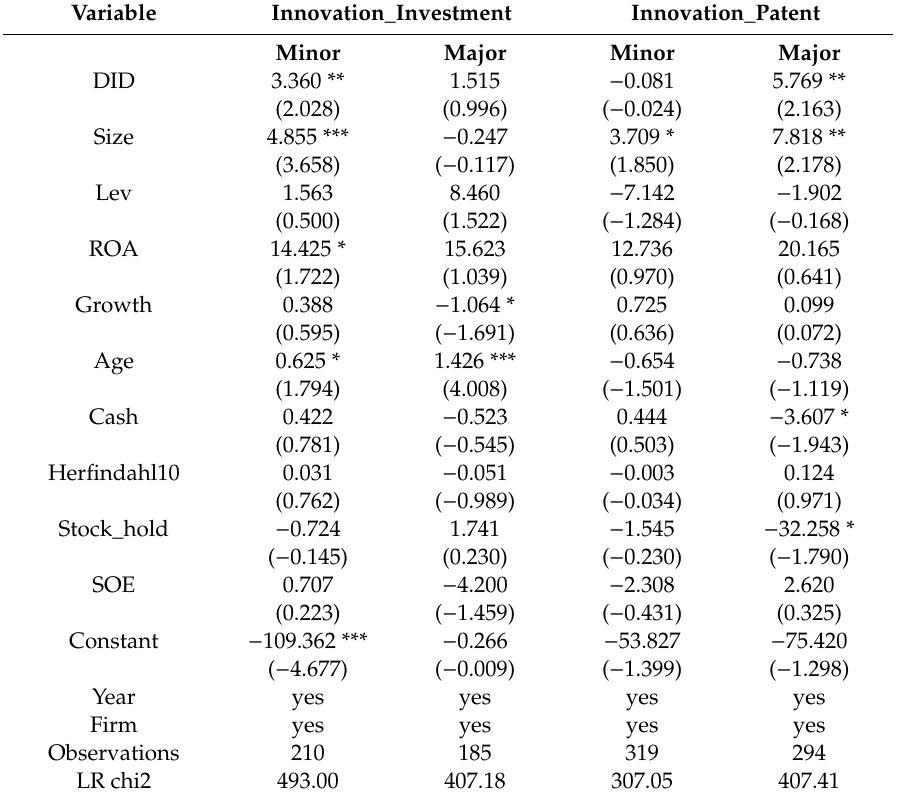
Table 5. Regression grouped by